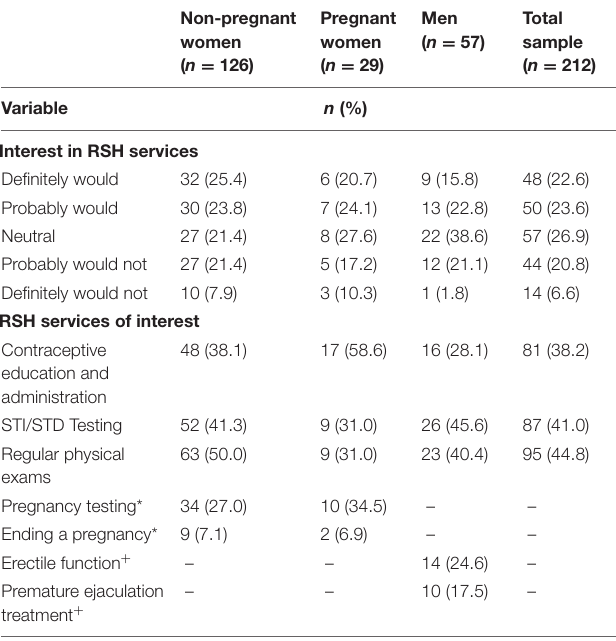
TABLE 2 | Interest in RSH services at MOUD